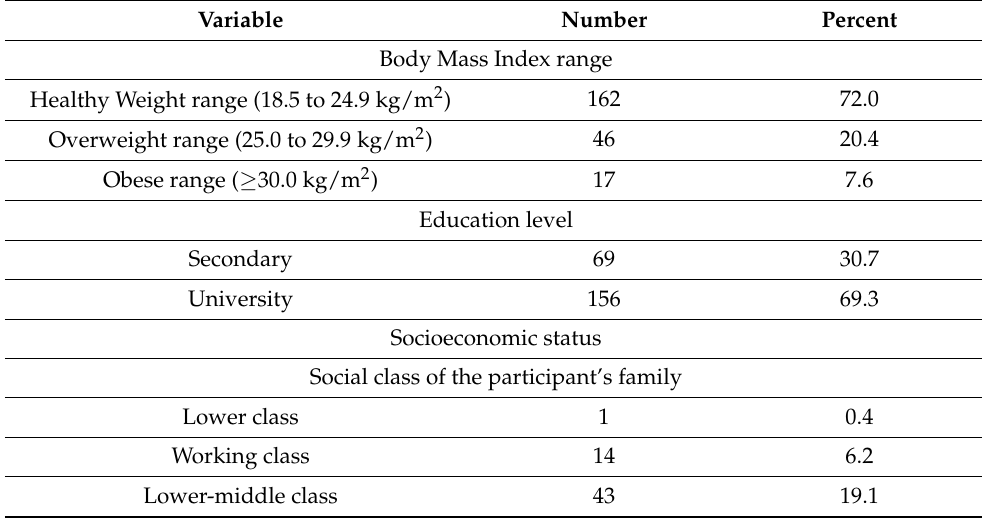
Table 3. Socioeconomic status and eating habits of adult women (N =